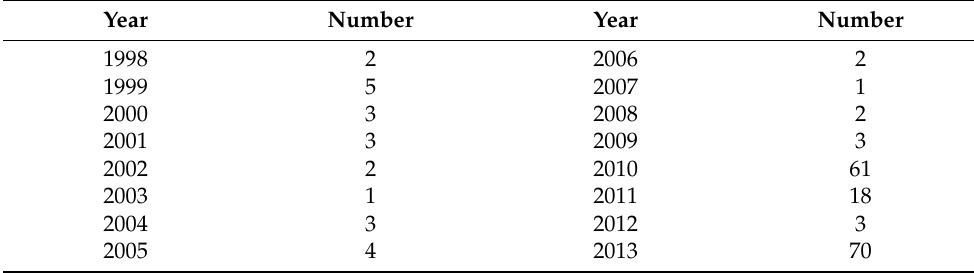
Table 3. Distribution of incidences by year in which the civil work